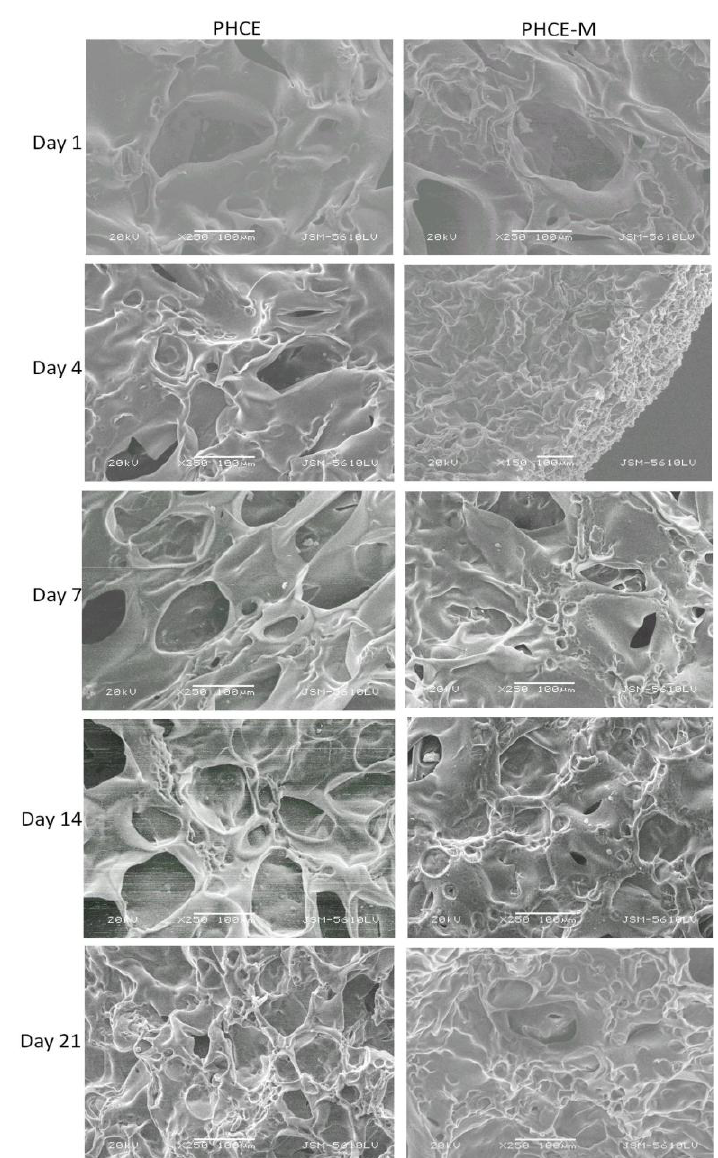
Figure 11. SEM of cellularized PHCE and PHCE-M scaffolds. No discernible cells on surface although scaffold becomes less porous over time. Scale bars at 100